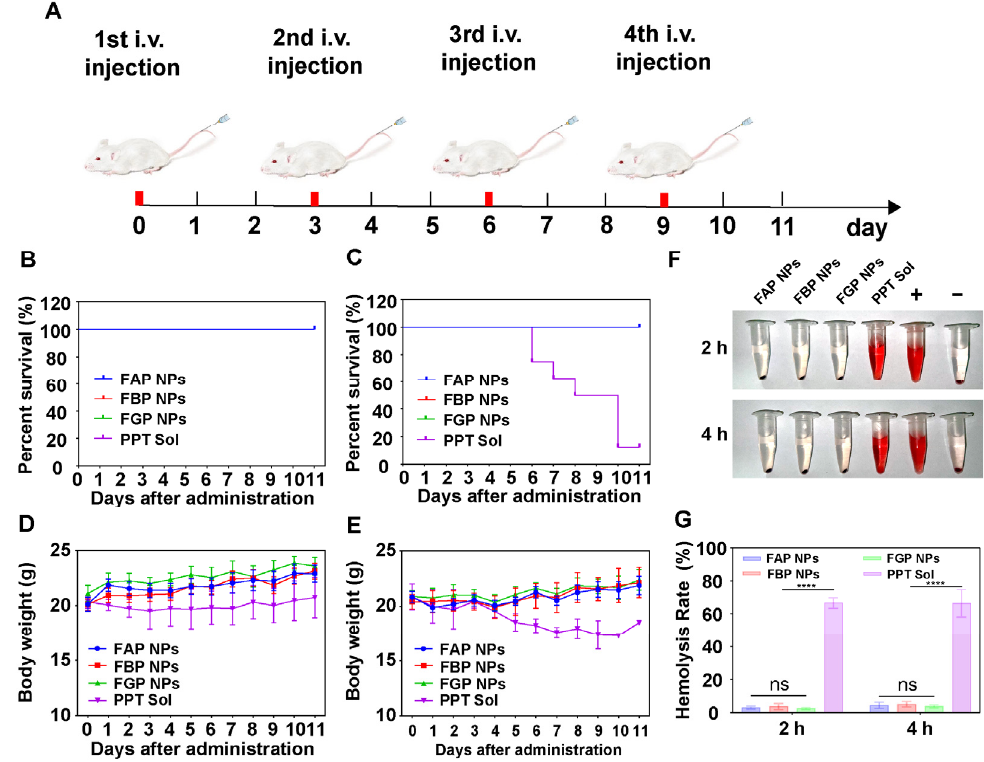
Figure 7. Maximum tolerated dose of FAP NPs, FBP NPs, FGP NPs and PPT solution. ( n = 8) ( A ) Schematic diagram of experimental process. Survival of healthy mice following i.v. injection of prodrug NPs and free PPT at a PPT-equivalent dose with ( B ) 10 mg/kg and ( C ) 20 mg/kg. Body weight changes following i.v. administration of prodrug NPs and free PPT at a PPT-equivalent dose with ( D ) 10 mg/kg and ( E ) 20 mg/kg. ( F ) Hemolysis image of prodrug NPs and PPT solution. Normal saline and deionized water were used as negative (0%) and positive (100%) controls, respectively. ( G ) Hemolysis rate (HR) of prodrug NPs and PPT solution. **** p < 0.0001. ns no